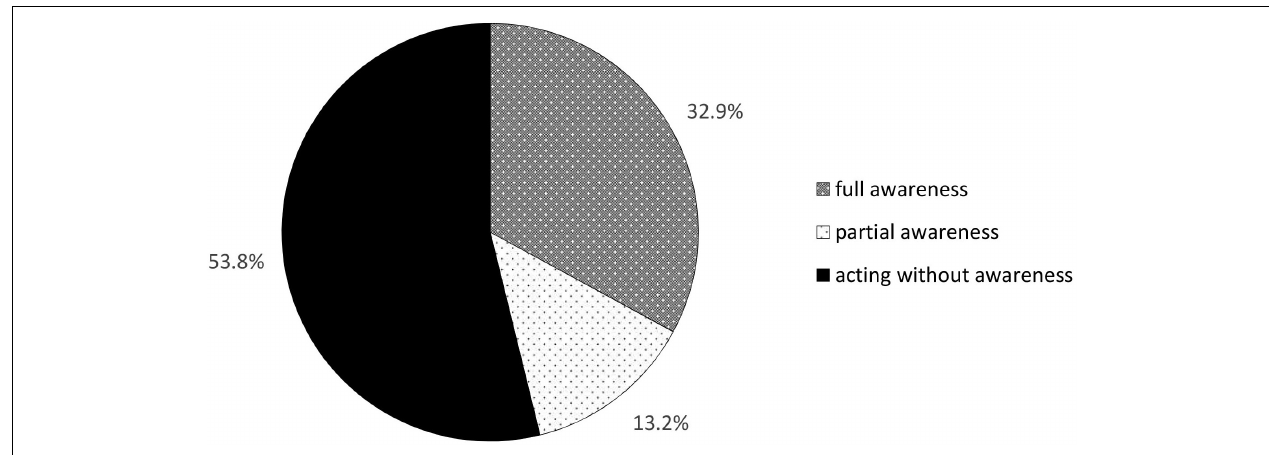
FIGURE 2 | Level of awareness for the signboard, based on walking behavior (avoidance of the signboard) and ability to report the signboard during recall or recognition. The amount of participants being fully aware of the signboard is significantly lower than recalling the signboard by chance ( p < 0.001), while tallying full and partial awareness did not differ from chance level at all ( p =